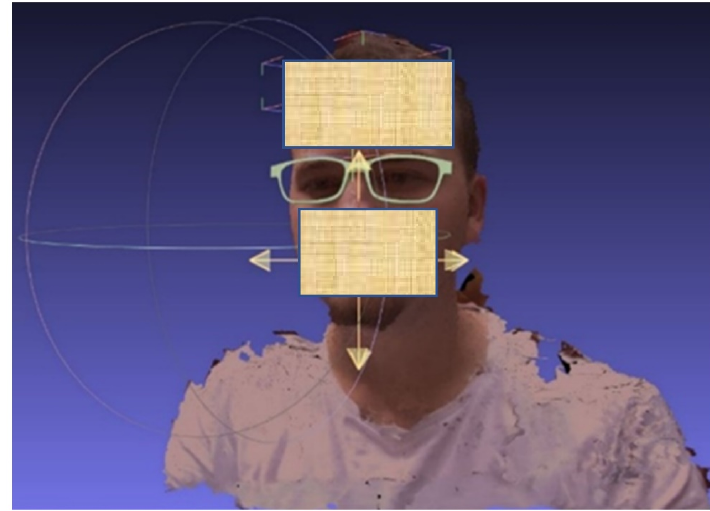
Figure 13. Final frame of the spectacles adapted to the 3D anatomical features of the wearer of the spectacles.